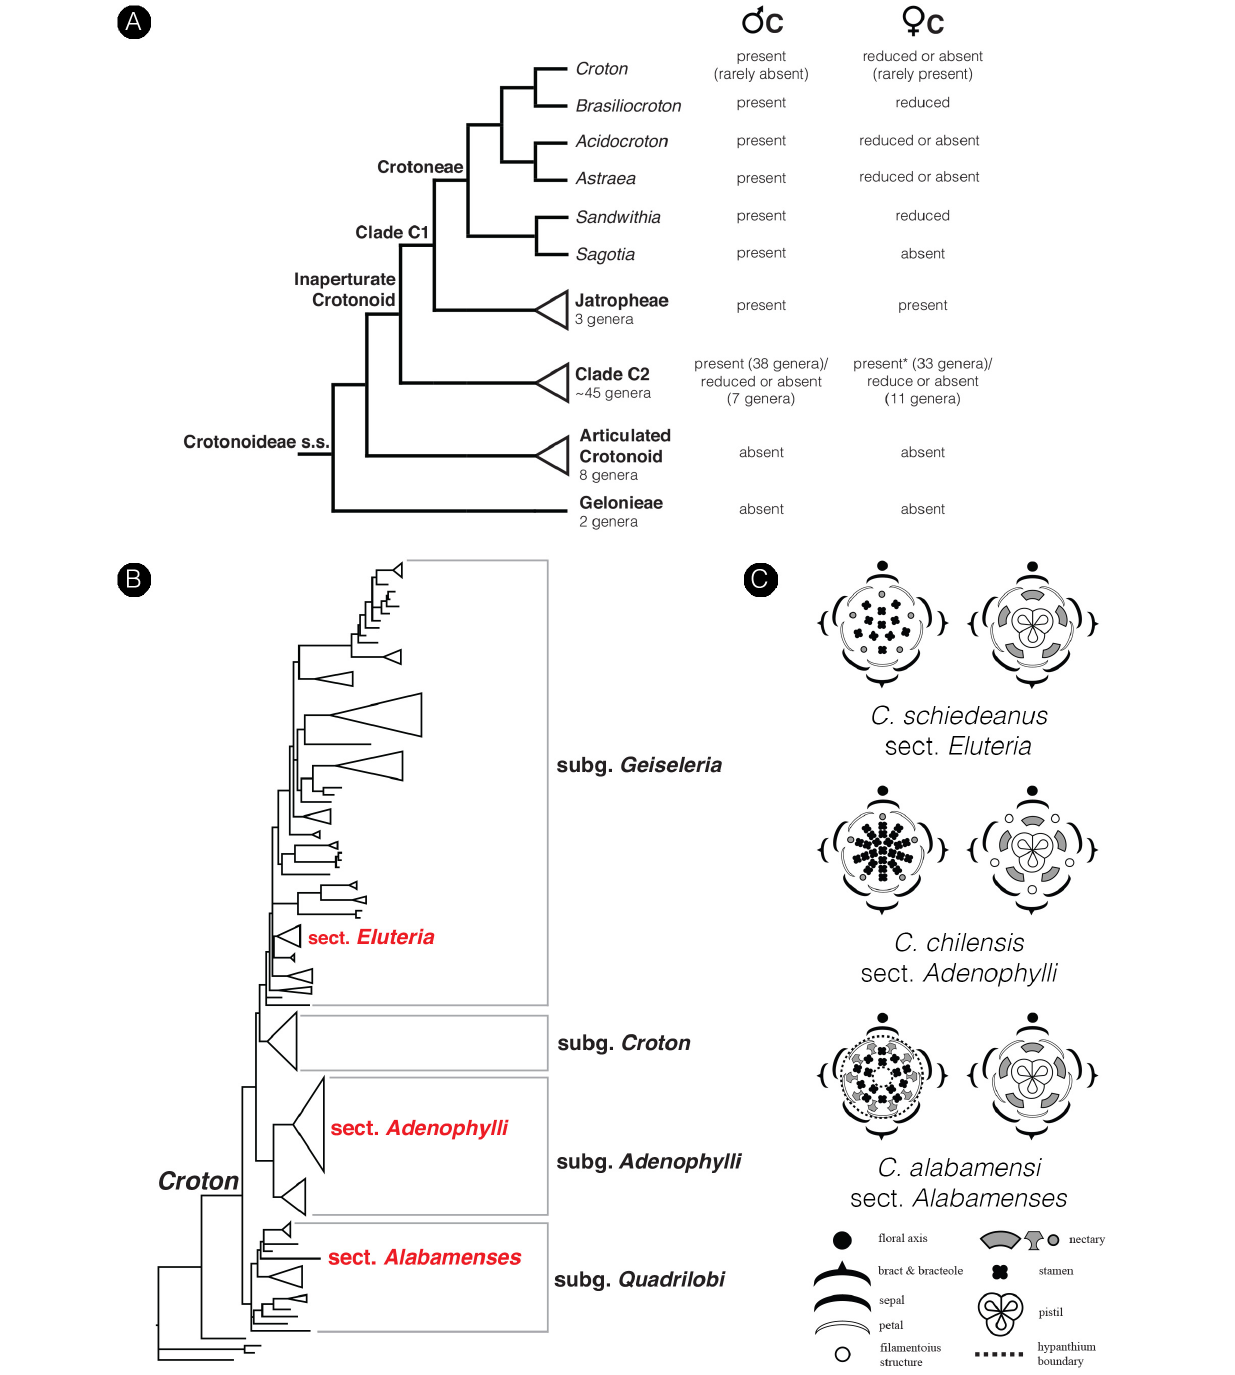
FIGURE 2 | Diagrams show the phylogenetic relationship in the subfamily Crotonoideae and the genus Croton mapped with a number of floral characters. (A) Simplified phylogenetic cladogram of the subfamily Crotonoideae shows relationships of all subgroups with the relationship of genera in the tribe Crotoneae emphasized (modified from Wurdack et al., 2005; van Welzen et al., 2020). The occurrence of petals in staminate and pistillate flowers were mapped on the tree with data from personal observation and the literature (e.g., Radcliffe-Smith, 2001; Webster, 2014). (Astersisk) There are no data about petals in pistillate flowers of the genus Tapoïdes . (B) Simplified phylogenetic phylogram of Croton indicating four subgenera. Sections which have representative species included in the present study are labeled (modified from van Ee et al., 2011). (C) Floral diagrams of both staminate and pistillate flowers from the three species of Croton used in this study. Floral diagrams were drawn following the symbols presented in Ronse De Craene